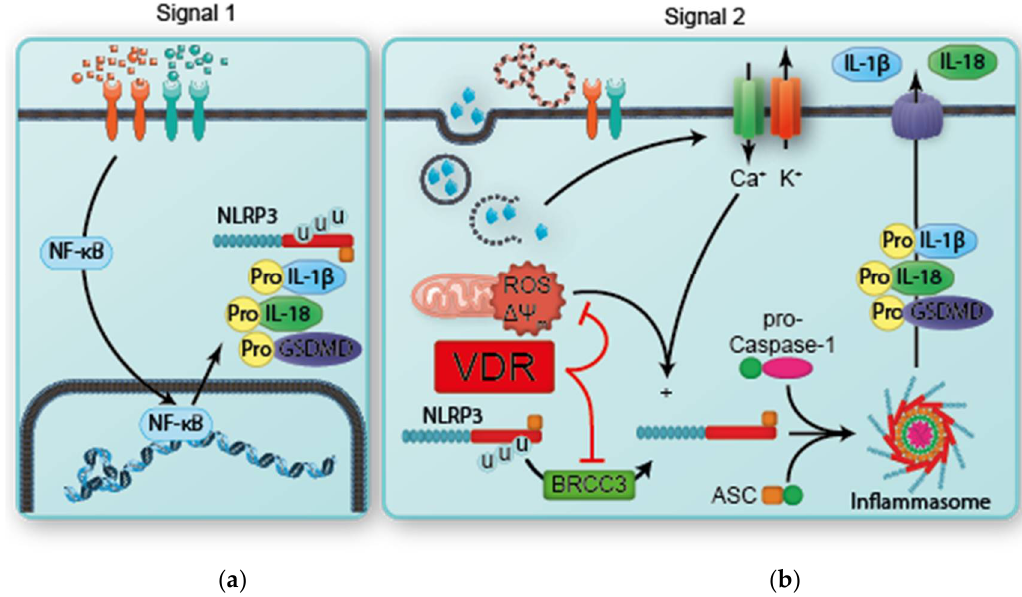
Figure 2. The canonical inflammasome activation pathway. ( a ) Signal 1 involves the activation of cell-surface PRRs by PAMPs and DAMPs. This activates downstream signalling with translocation of NF-ĸB to the nucleus and upregulation of the expression of NLRP3, pro-IL-1β, pro-IL-18, and pro-GSDMD. ( b ) Signal 2 involves activation of the primed components by a range of PAMPs/DAMPs/HAMPs that include extracellular oxidised DNA, extracellular ATP, lysosomal degradation products, calcium influx and potassium efflux, mitochondrial damage with altered membrane potential, and the release of oxidised mitochondrial DNA. BRCC-3-mediated deubiquitination of NLRP3 allows for the activation and oligomerisation of NLRP3 with ASC and pro-caspase-1. After oligomerisation, conformational change activates caspase-1, allowing cleavage and release of IL-1β, IL-18, and GSDMD. GSDMD translocates to the cell membrane where it allows for rapid release of IL-1β and IL-18 into the external environment and mediates pyroptosis. PRR—pattern-recognition receptor. PAMP—pathogen-associated molecular pattern. DAMP—danger-associated molecular pattern. HAMP—homeostasis-altering molecular process. NF-ĸB—nuclear factor kappa-light-chain-enhancer of activated B cells. NLRP3—nucleotide-binding domain-like receptor protein 3. IL—interleukin. GSDMD—gasdermin D. ATP—adenosine triphosphate. DNA— deoxyribonucleic acid. BRCC-3—BRCA1/BRCA2-containing complex, subunit 3. ASC—apoptosis-